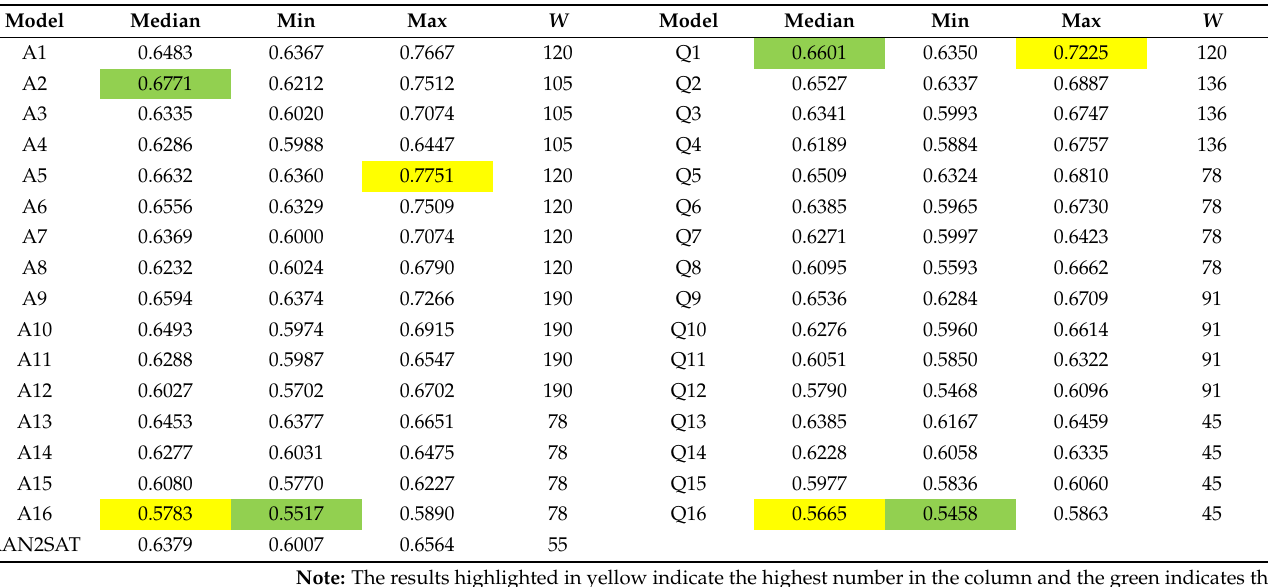
Table 16. Maximum and minimum Sokal results for models in both types of logic δ 1 2 SAT ρ , δ 2 2 SAT ρ and RAN2SAT details by Wilcoxon test for median.